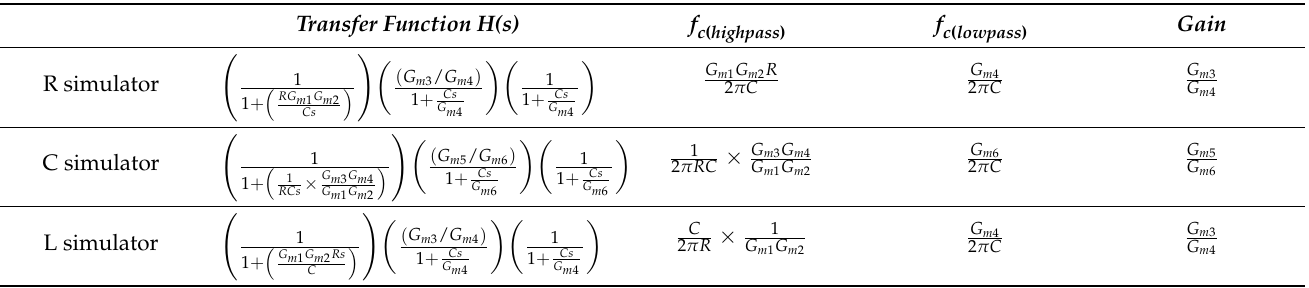
Table 2. Transfer function, highpass frequency, lowpass frequency, and gain of each filter implemen- tation.